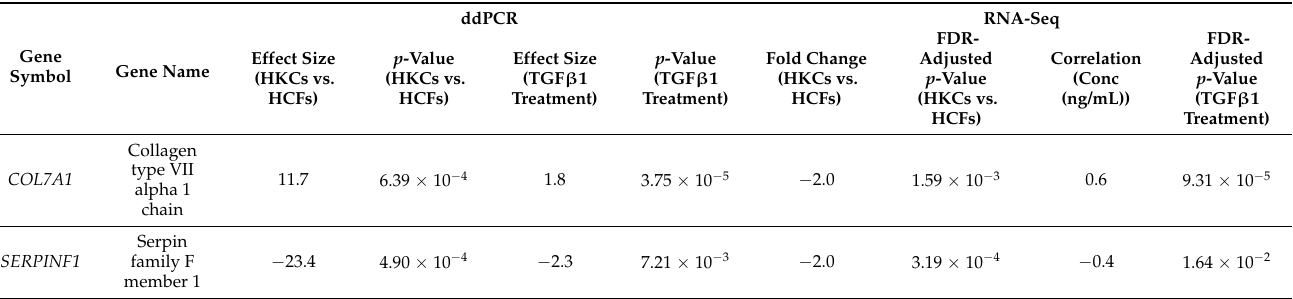
Table 7. Validated differentially expressed genes with ddPCR compared with RNA-Seq for KC-altered genes with TGF β 1 treatment.